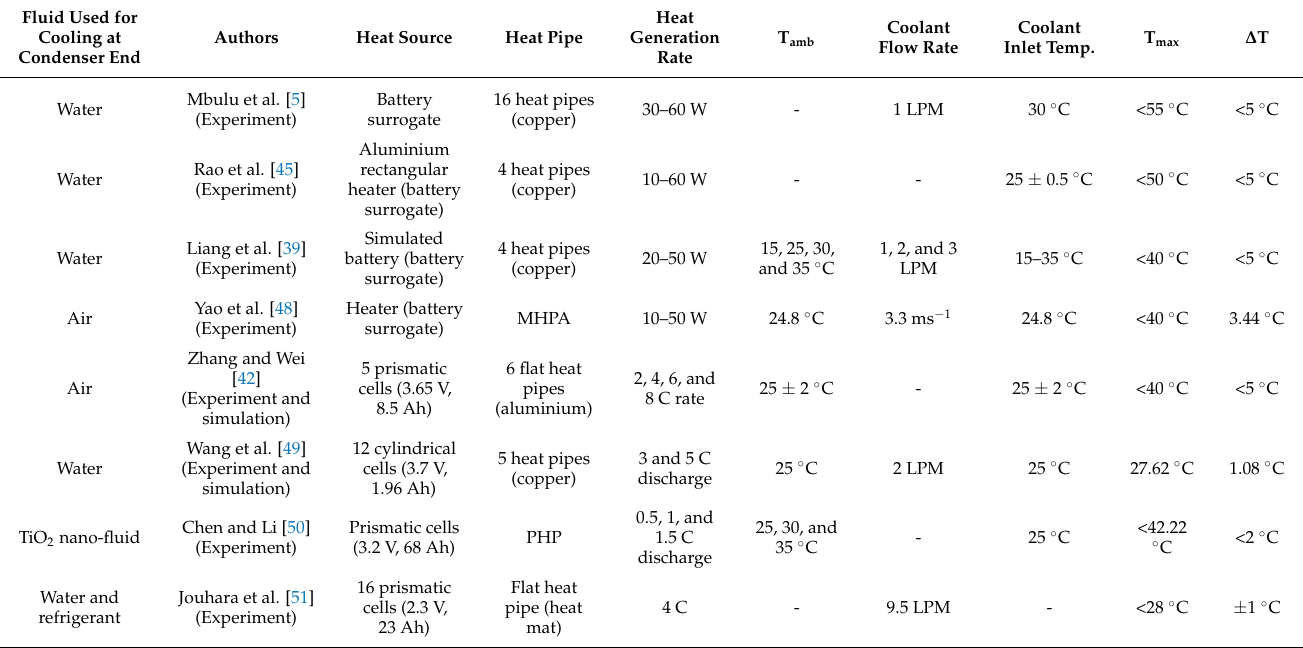
Table 2. Summary of studies of the heat pipe cooling system at different heat generation rates and coolant